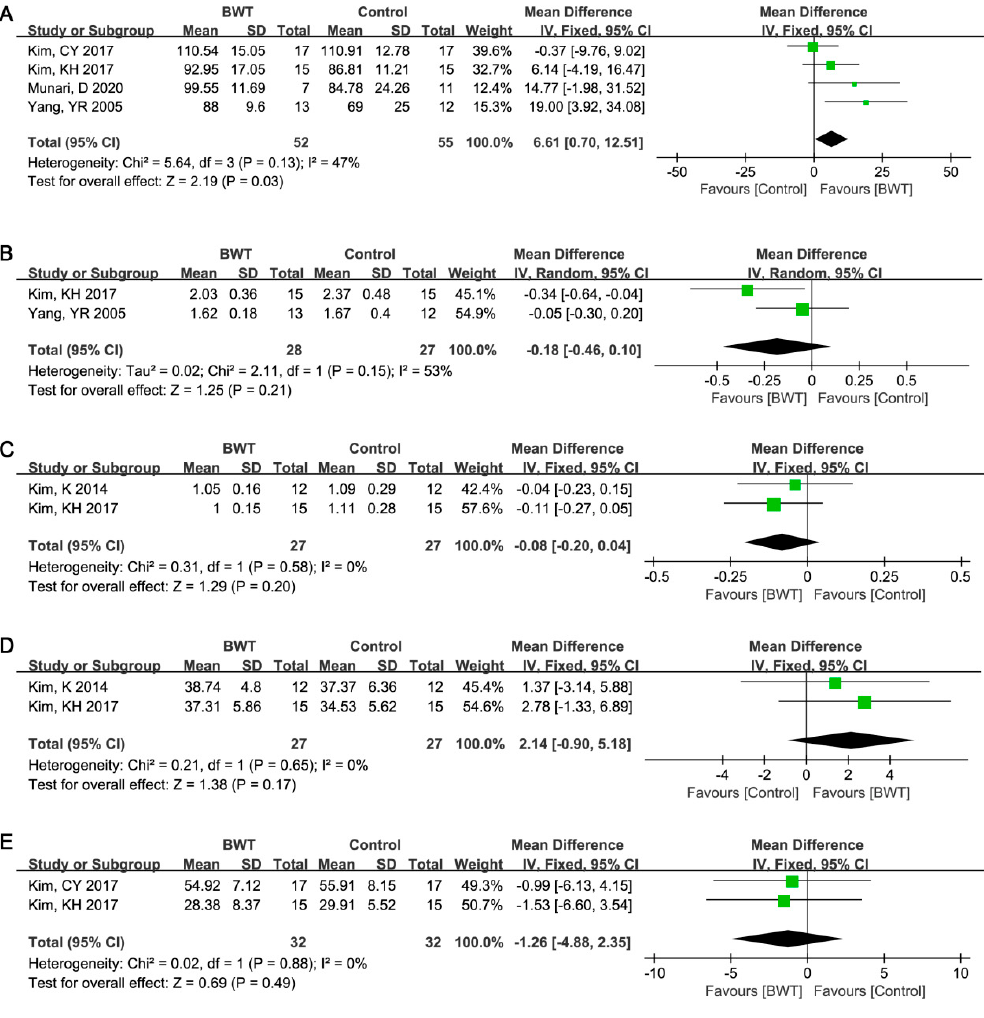
Figure 4. Forest plot for meta-analyzing the role of backward walking training and conventional treatment on stride length, gait cycle, paretic step time, paretic single support, and total double support. ( A ) Stride length; ( B ) gait cycle; ( C ) paretic step time; ( D ) paretic single support; and ( E ) total double